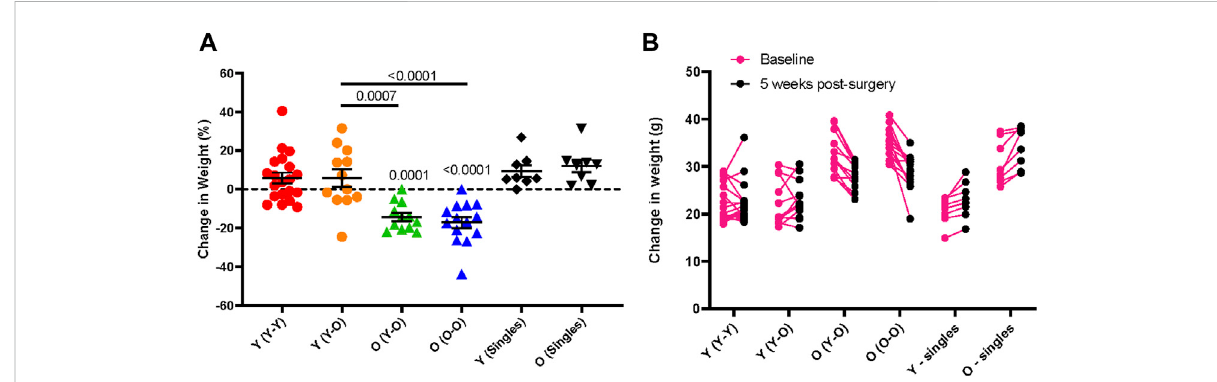
FIGURE 5 Age-dependent changes in body weight following parabiosis. Body weight change from baseline to 5-weeks following parabiosis surgery in females and males is depicted as (A) percentage change (Surgical pairs n = 6 – 10, singles n = 8; one-way ANOVA with multiple comparison testing) and (B) change in grams (g). Young mice maintain body weight and old mice lose weight after